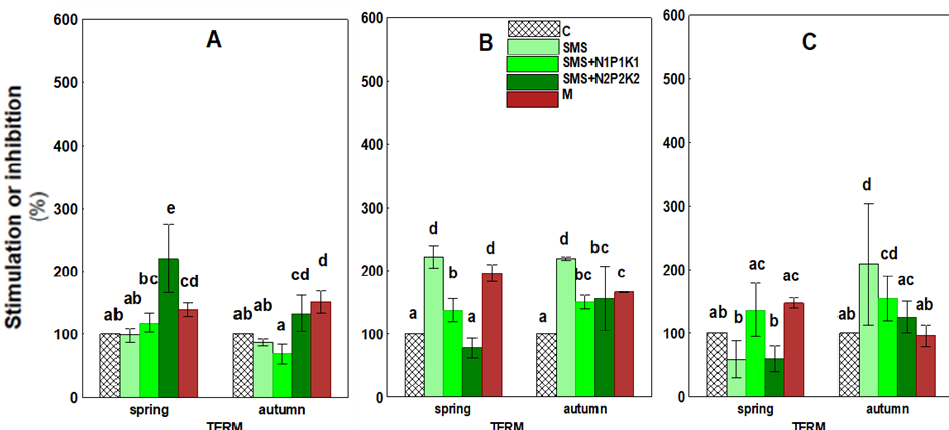
Figure 7. Growth index Lepidium sativum in soil under different treatment strategies. ( A )—1st year; ( B )—2nd year; ( C )—3rd year. C—control soil; SMS—soil + spent mushroom substrate; SMS + N1P1K1—soil + spent mushroom substrate + mineral fertilization N1P1K1; SMS + N2P2K2—soil + spent mushroom substrate + mineral fertilization N2P2K2; M—soil + manure. The vertical lines indicate the standard deviation. Different letters above the columns indicate significant differences at p < 0.05, and each year was analyzed independent of each other.